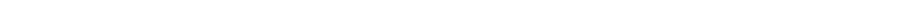
Figure 2. Urban Growth Scenarios in the Central Four Counties of the San Joaquin Valley (Scenario 2 was omitted because of its similarity to Scenario 1 at this